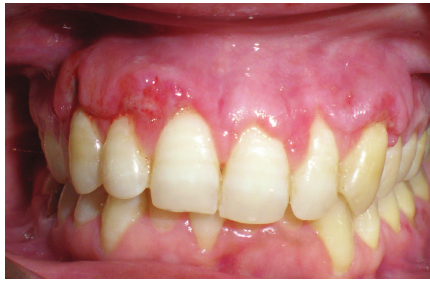
Figure 4: 10 days